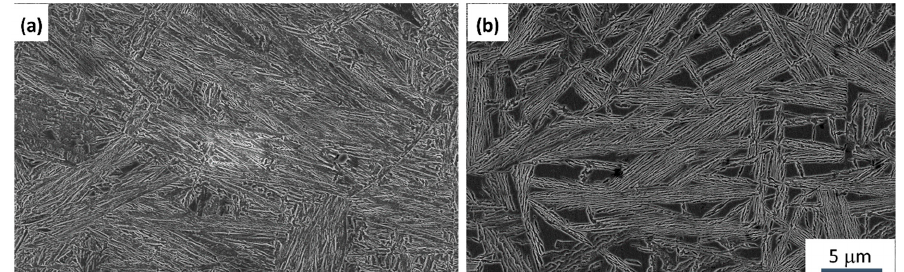
Figure 4. SEM images of the bainitic microstructure obtained after isothermal transformation at 300 °C in ( a ) Steel 1 and ( b ) Steel 2. The darker long slender features are the plates of bainitic ferrite ( α b ), and the lighter phase found as films and more blocky type features correspond to retained austenite ( γ ).